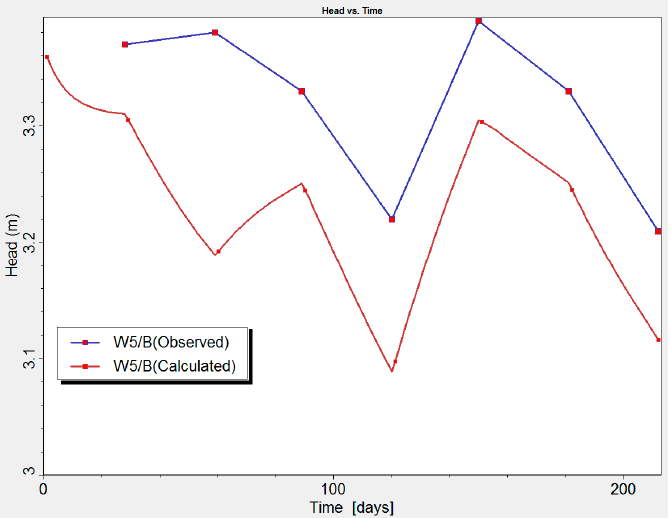
Figure 13. Head versus time at the monitoring piezometer-W5 (Scenario 4).